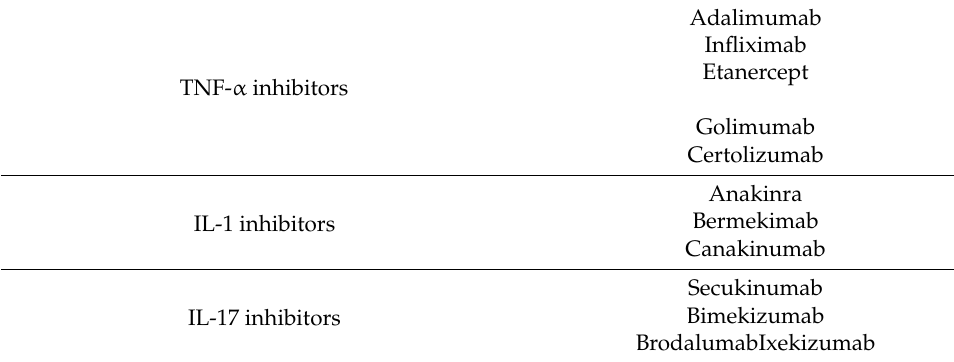
Table 4. A summary of immunomodulatory drugs and inhibited